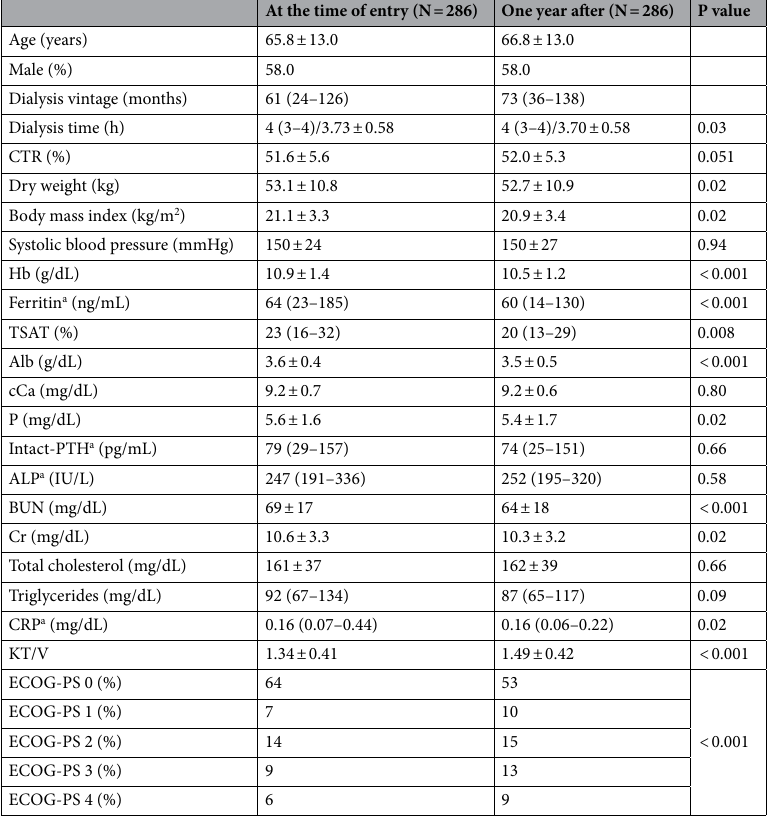
Table 1. Patient background. Paired-t-test, Wilcoxon sum test, and McNemar test were used for analysis. CTR cardiothoracic ratio, Hb hemoglobin, TSAT transferrin saturation, Alb albumin, cCa corrected calcium, P phosphate, PTH parathyroid hormone, ALP alkaline phosphatase, BUN blood urea nitrogen, Cr creatinine, CRP C-reactive protein, PS , ECOG-PS Eastern Cooperative Oncology Group performance status. a Median (interquartile